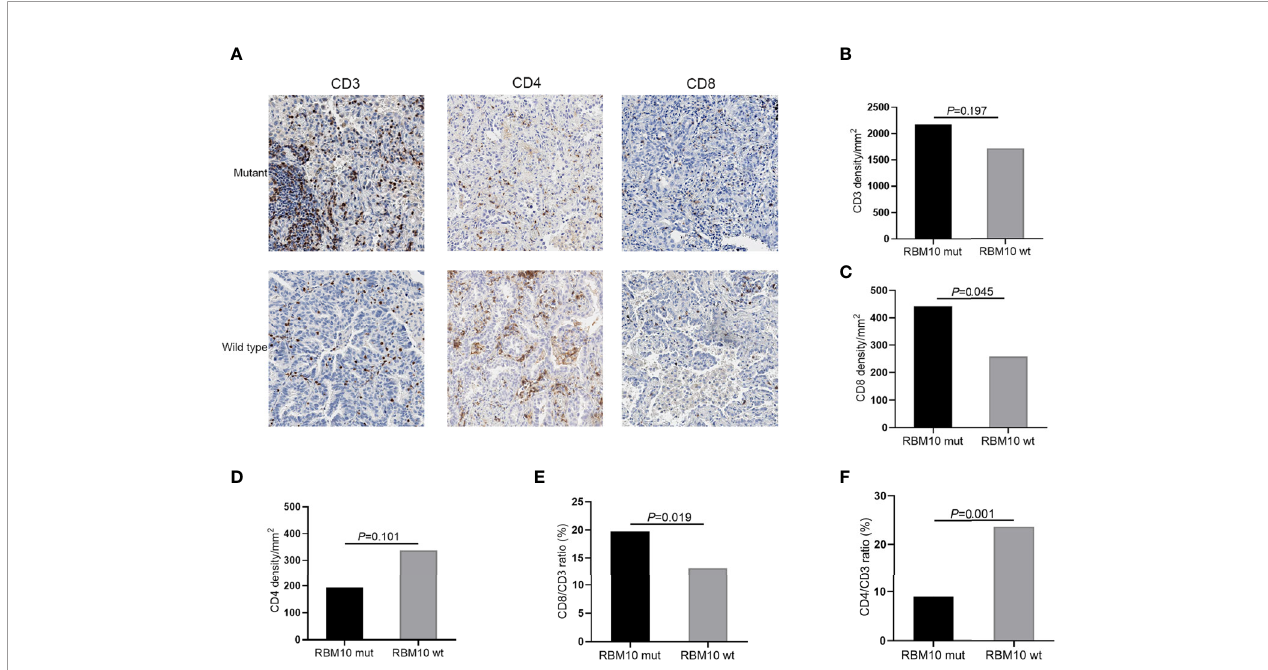
FIGURE 5 | IHC analyses of T cell in fi ltration in FFPE tumor samples of GGN cohort. (A) Representative images of CD3, CD4 and CD8 immunostaining. (B – D) CD3+T cell density (B) and CD8+T cell density (C) are higher in the RBM10 mutant LUADs, and CD4+T cell density is lower in the RBM10 mutant group (D) . (E, F) CD8/CD3 ratio is higher in RBM10 mutant group than in the wild-type group (E) , and CD4/CD3 ratio is lower (F)